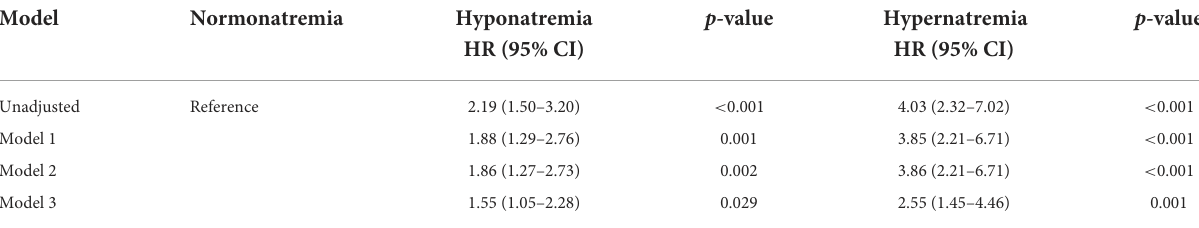
TABLE 2 Association of sodium with risk of all-cause mortality in patients with AF.